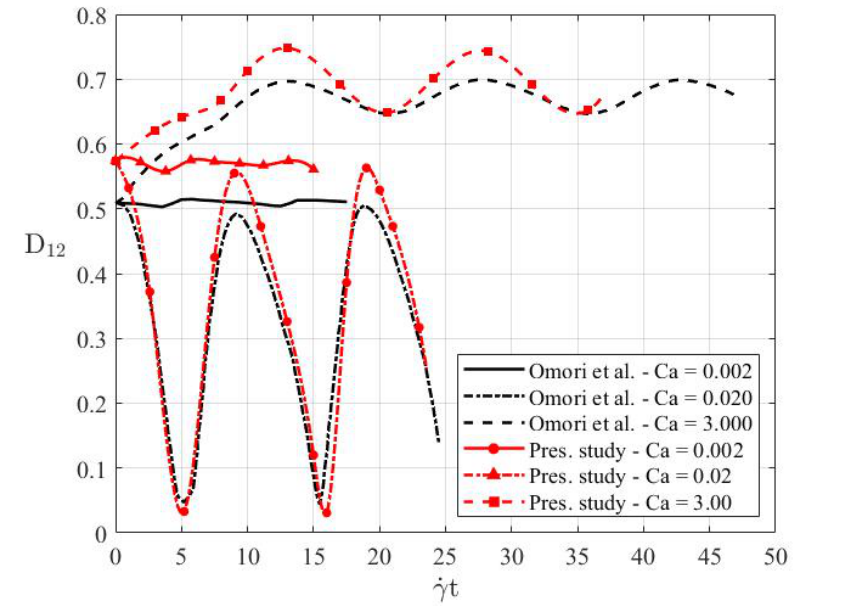
Figure 5. Validation of the present RBC model with those of Omori et al.